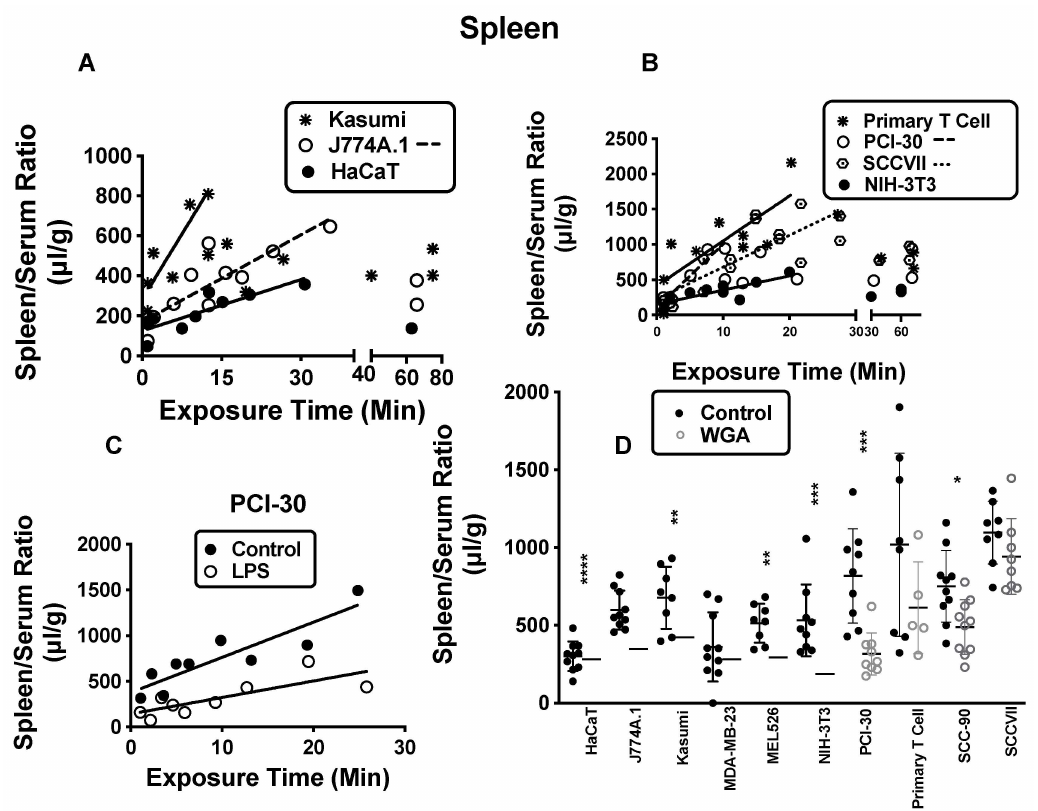
Figure 4. Spleen sequestration of exosomes. In ( A ) (Kasumi, asterisk with solid line n = 13; J774A.1, open circle with dashed line, n = 13; HaCaT, solid circle with solid line, n = 11) and ( B ) (Primary T cell asterisk with solid line, n = 13; PCI-30, open circle with dashed line, n = 13; SCCVII, targeted circle with dotted line, n = 20; NIH-3T3, solid circle with solid line, n = 12), the patterns for spleen for different exosome types are shown. In ( C ), a decrease in sequestration with LPS as exemplified by PCI-30 is shown (n = 9/group). In ( D ), six exosome types (n = 10 for control and WGA for J774A.1 and SCC-90; n = 9 for control and WGA for NIH-3T3 and PCI-30; n = 8 for control and WGA for Kasumi and MEL526) whose sequestrations were suppressed by WGA are shown. * p < 0.05; ** p < 0.01, *** p < 0.001, **** p << 0.001. See Figure S2 for exosomes not shown here. Regression analysis was used in panels ( A – C ) and t -tests in panel ( D